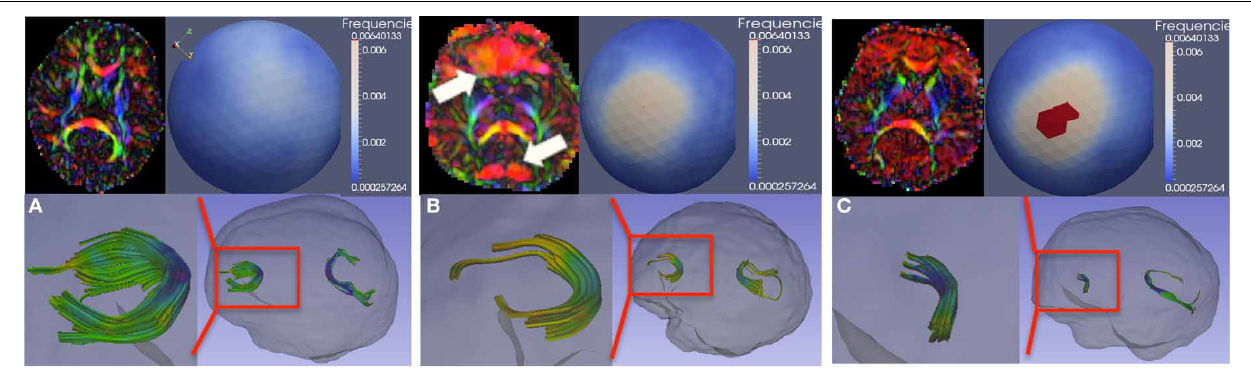
FIGURE 6 | Vibration artifacts. (A) Artifact free scan. Top-left, a representative axial slice of the color-FA map. Top-right, spherical histogram of the PD distribution within the entire brain. Bottom-right, tractography of genu and splenium of the corpus callosum. Bottom-left, genu tract in more